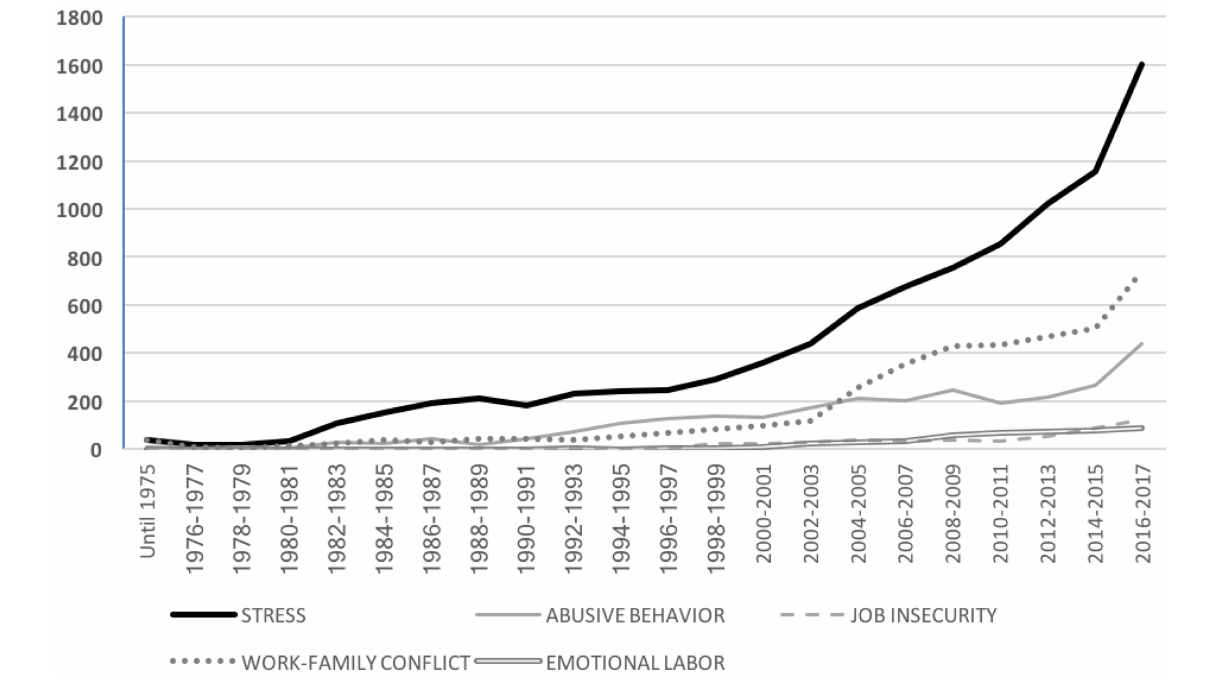
FIGURE 1 | Total number of articles in the most common psychosocial risk